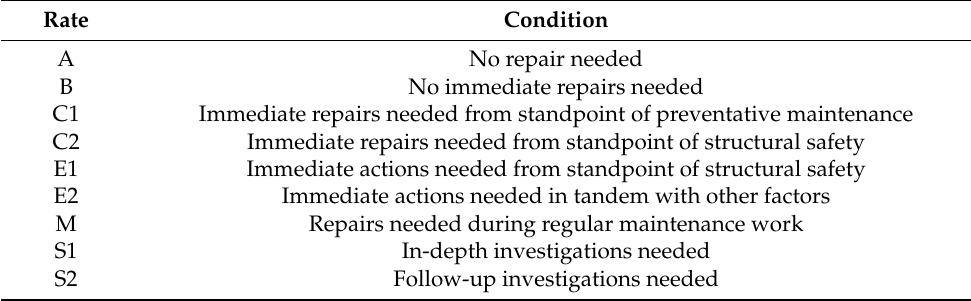
Table 2. Assessment of maintenance urgency for bridge element in Japan.